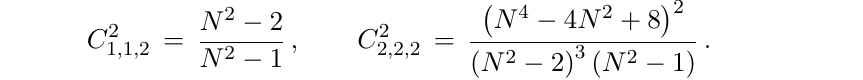
Figure 1 . The allowed region for C 1 ; 1 ; 2 , C 2 ; 2 ; 2 from localization for classical groups G . Extremal points corresponding to free theories are marked by red points and the planar theory in the fun- damental representation is marked by a dotted red curve. The U(1) theory at ( value of the coupling) has the same OPE coe(cid:14)cients as the strong coupling limit of any other case that we looked at. The notation for the theories is G R , where the representation R is given by its Dynkin